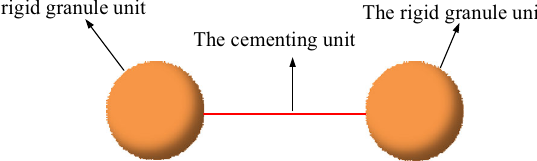
Fig. 2 Basic components of the microstructure of weakly cemented sandstone